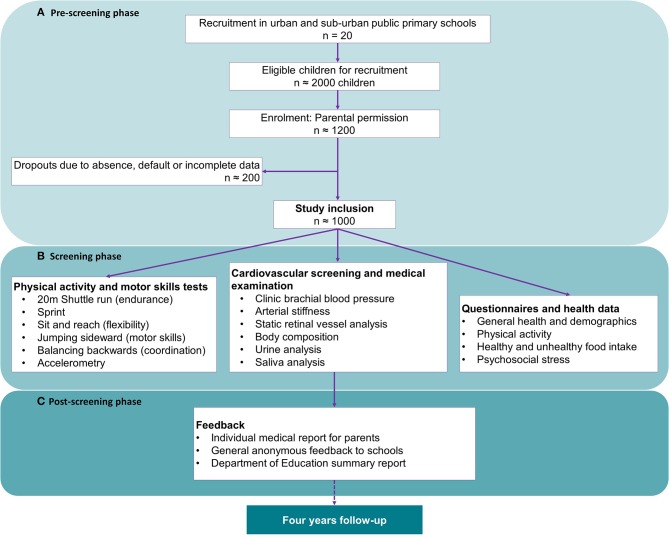
Flow diagram of the three phases of the baseline study population and data collection. (A) The pre-screening phase including the planning, organization, permission and recruitment; (B) The screening phase which involved participant assent and consent, and baseline data collection; and (C) The post-screening phase comprises of a multifaceted feedback process and data analysis.